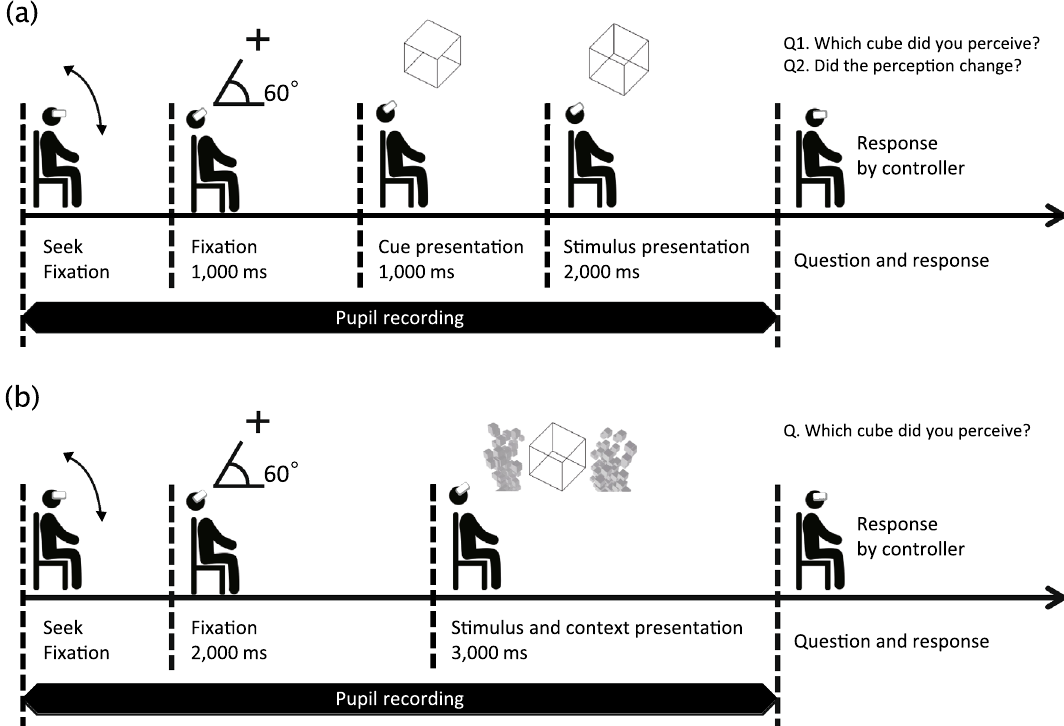
Figure 2. Illustration of the timeline of the experiments. (a) Flow of one trial in Experiment 1. Participants shook their heads and looked for a fixed fixation point at one of the five angles. In this example, the trial is for 60°. After gazing at the fixation point for 1000 ms, a cue was presented for 1000 ms, and then the stimulus was presented for 2000 ms. Participants then responded regarding their perception. (b) The flow of one trial in Experiment 2. The general flow was similar to Experiment 1, but the fixation point was presented for 2 s, and the stimulus and background context were presented for three seconds concurrently. The question has been simplified to one. Please also see Supplementary File